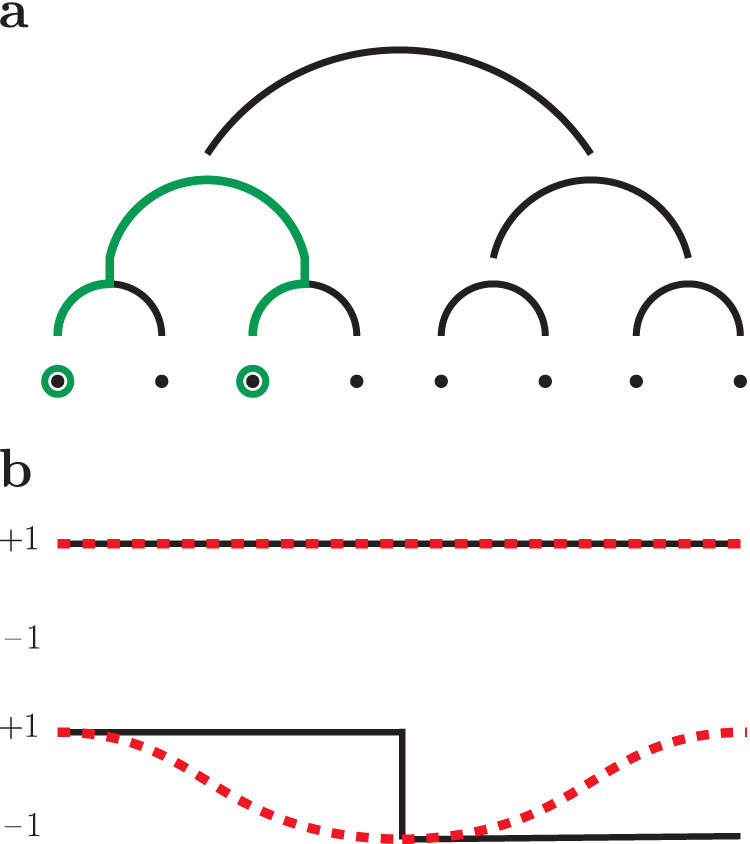
Hierarchical Edwards-Anderson model in a magnetic field (HEA) with k = 3.(a) Structure of spin-spin interactions: each dot represents a spin, and arcs represent interactions between spins below them. The green path goes from the bottom to the top of the hierarchical tree until a common arc between the two circled spins is found: since this requires ascending two hierarchical levels, the hierarchical distance between the two spins circled in green is dij = 2. (b) Long-wavelength Fourier modes: real part of the Fourier modes  for the HEA (black solid lines), where the index i = 0, …, 2k − 1 runs over the lattice sites from left to right, and the Fourier modes take values 1 and −1. We also plot the real part of the Fourier modes exp(2πip i/2k) for a one-dimensional spin glass where spin-spin interactions decay according to the Euclidean distance |i − j| (red dashed lines). Top: first Fourier mode, corresponding to p = 0 for both the HEA and for the power-law spin glass. Bottom: second Fourier mode, corresponding to p = 2k−1 for the HEA and to p = 1 for the power-law spin glass.